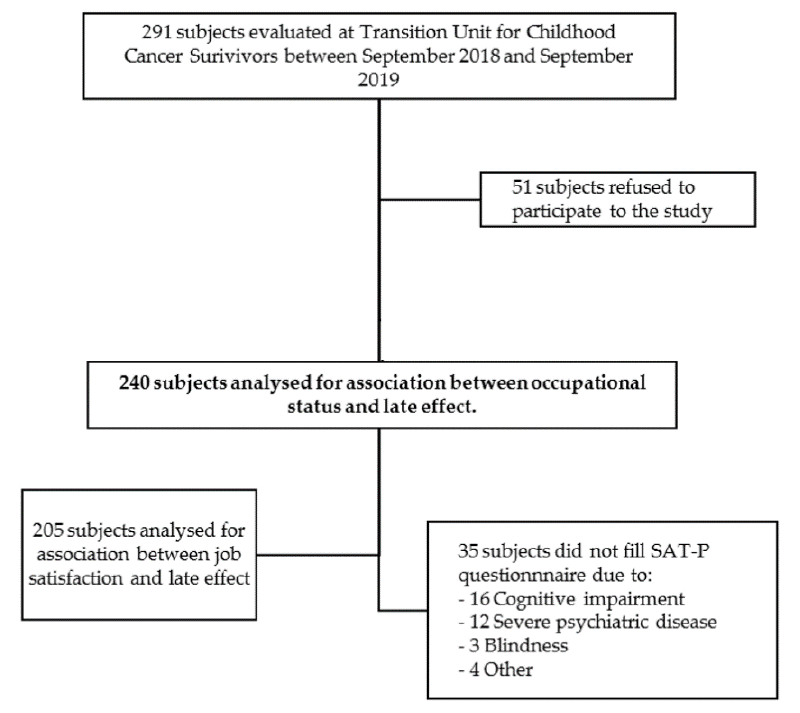
Figure 1. Inclusion process of participants. Table 1. Socio-demographic and clinical characteristics according to occupational